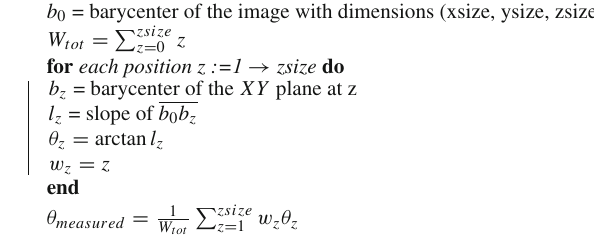
Algorithm 1: Calculating 3D angle from